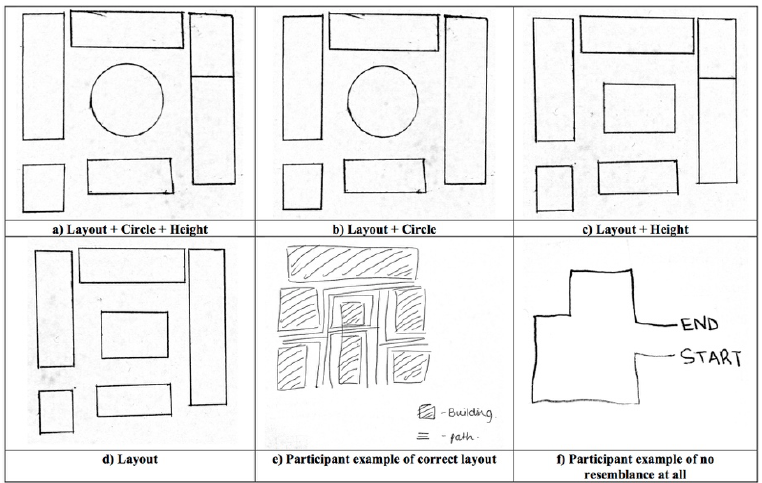
Figure 8. Examples of the different categories for the sketch (Task4).